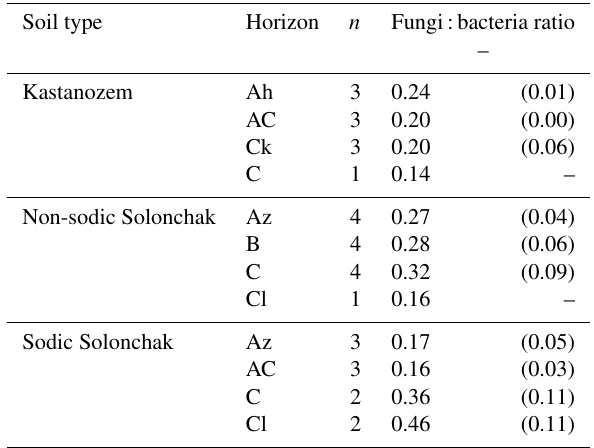
Table 4. Fungi:bacteria ratio as a function of soil type and horizon. Given are the arithmetic means and the standard error of the mean in